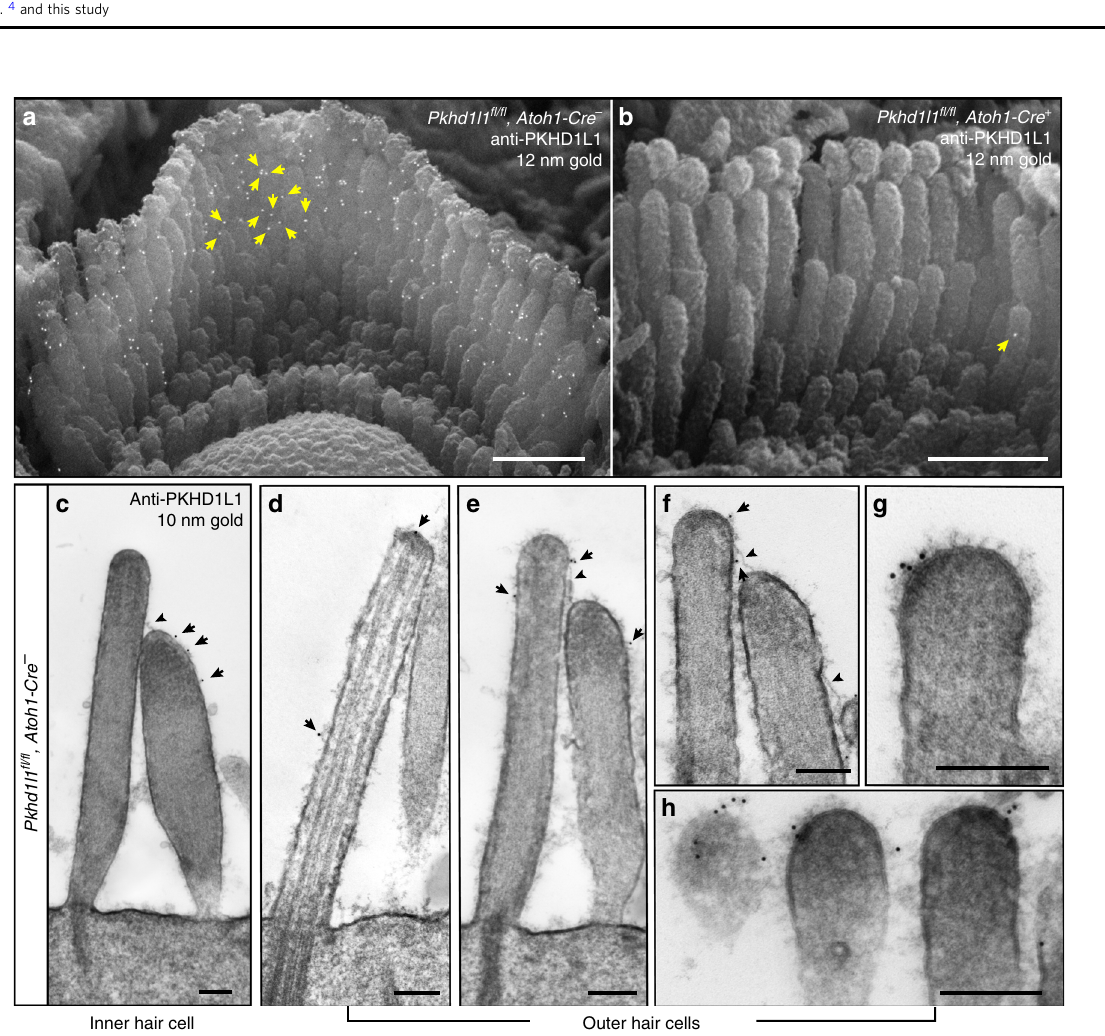
Fig. 4 Immunogold localization of PKHD1L1 towards the tips of OHC and IHC stereocilia (P4). a , b SEM photomicrographs of P4 OHC stereocilia bundles. Multiple 12-nm gold beads in a (yellow arrows point to some gold beads) were detected on the surface of control Pkhd1l1 fl / fl , Atoh1-Cre − OHCs, but not mutant Pkhd1l1 fl / fl , Atoh1-Cre + hair cells, further validating the antibody speci fi city at the EM level in b (yellow arrow shows nonspeci fi c label). c – h 10-nm gold beads were detected on TEM photomicrographs. Black arrows point to gold beads on the surface of IHC stereocilia c , OHC kinocilia d , and stereocilia e – h ; black arrowheads point to the tip links c , e , f . Scale bars: a – b , 1 µ m; c – h , 200